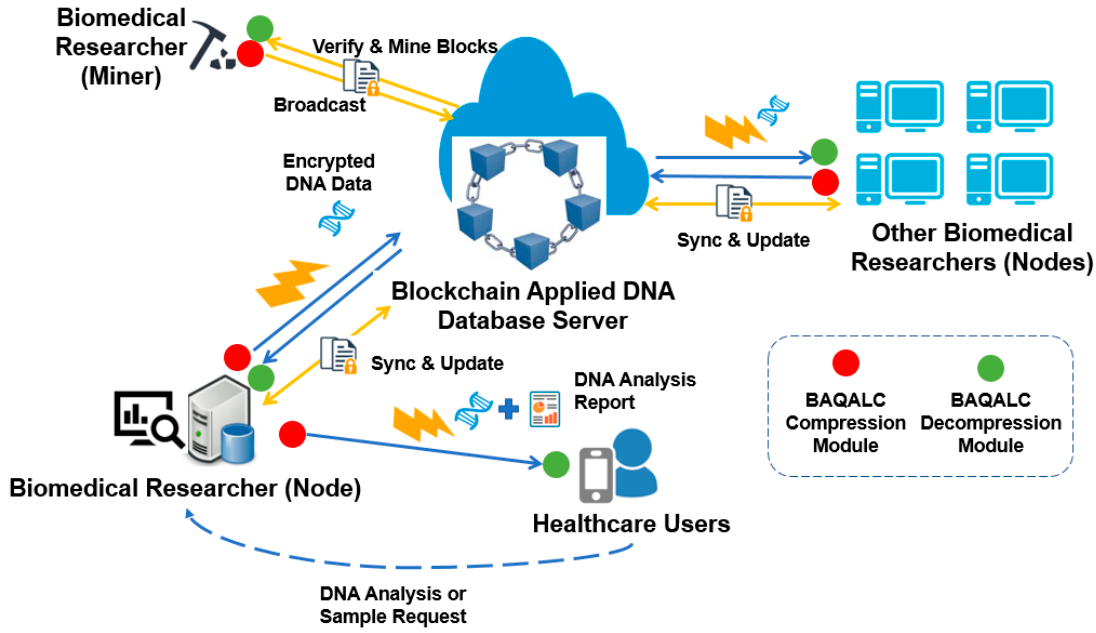
Figure 2. Overall System Architecture of BAQALC Modules.